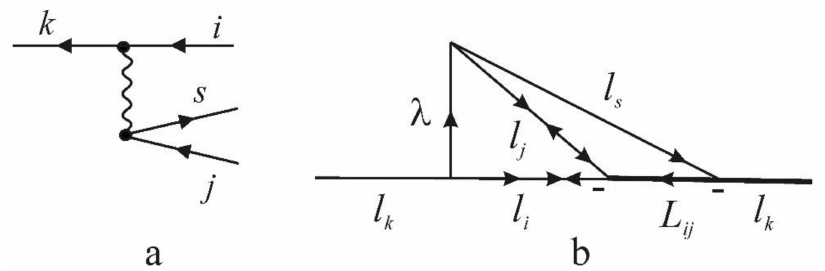
Figure 1. Graphs for the satellite’s excitation. ( a ) Feynman diagram for the satellite excitation. Arrows directed from left to right (right to left) denote particles (holes), wavy line denotes Coulomb interaction. ( b ) angular momentum graph, corresponding to the Feynman diagram ( a ). Angular momentum graph for the spin part in which interaction line is removed should be